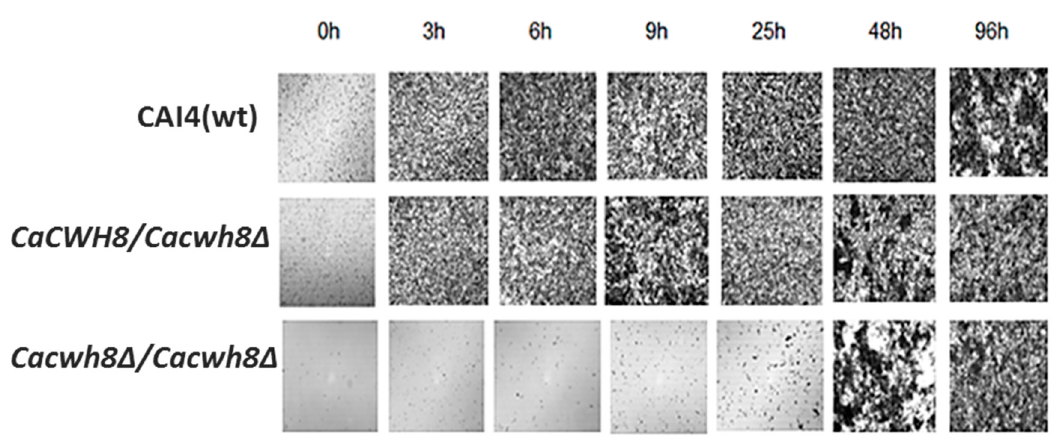
Figure 13. Biofilm formation in the wild type (CAI4) strain and the CaCWH8 mutants. Three milliliters of cell suspension (1 × 10 6 cells per mL) was transferred onto sterile 55-mm Petri dishes and incubated at 37 °C. Nonadherent cells were washed away and biofilm was dried and photographed under a light microscope with 10× magnification To check the ability to form hyphae, the three strains were cultivated in hyphae-inducing conditions, i.e., in the presence of 10% horse serum and on solid Spider medium. The wild type strain formed hyphae on both media, the hemizygote did so on horse serum only, while the double mutant failed to produce hyphae in either conditions (Figure 14).